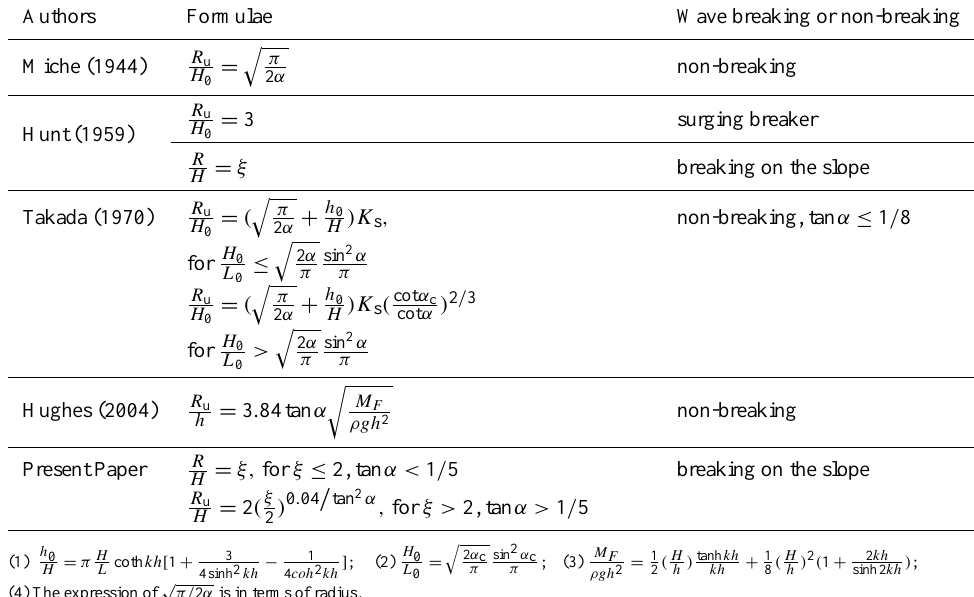
Table 1. Different empirical formulae for regular wave